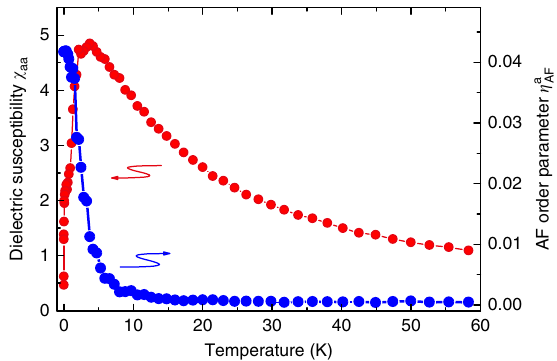
(cid:9) . Here, N is the number of